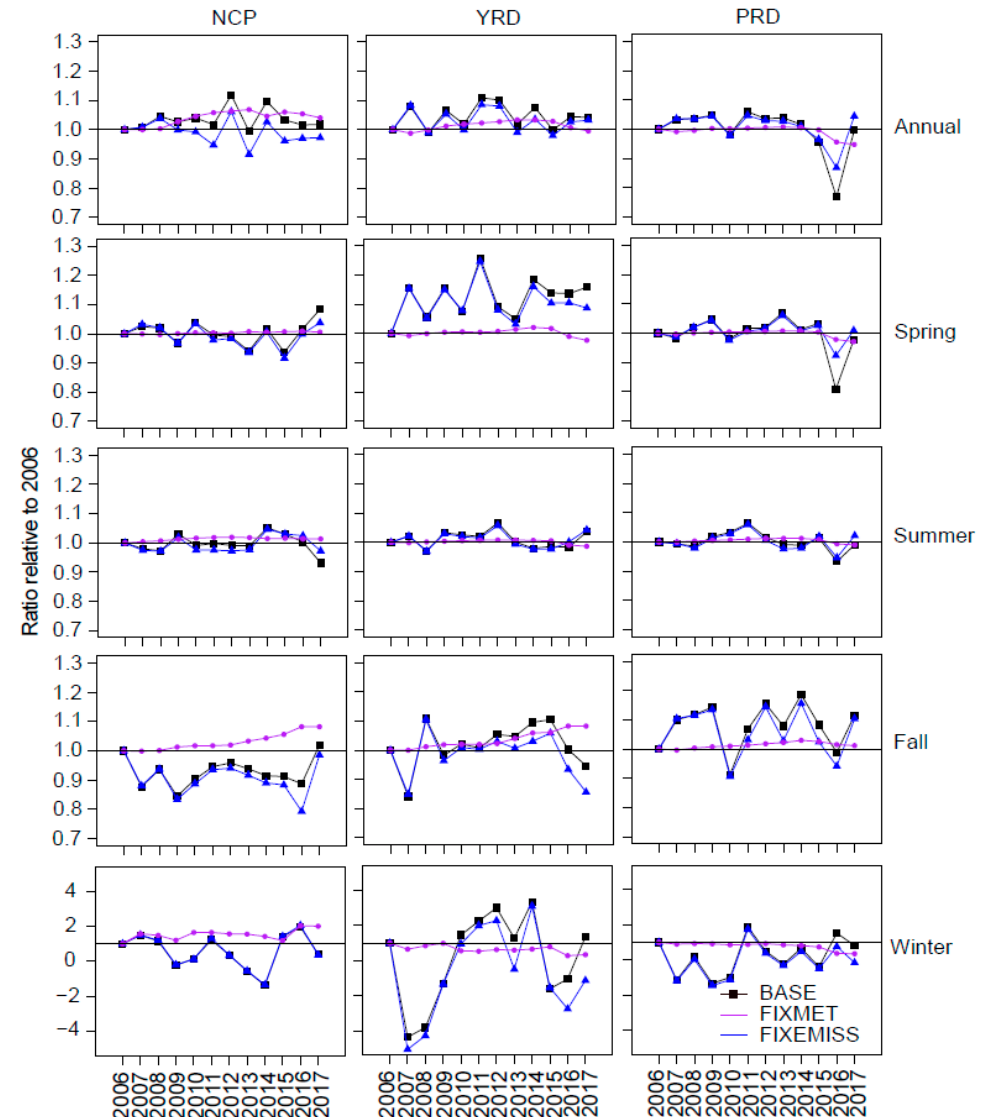
Figure 5. Annual and seasonal mean correlation coefficient of daily PM 2.5 and daily AOD (r PM-AOD ) relative to their values in 2006 in GEOS-Chem simulations in 2006–2017. Three experiments are shown: varying meteorology and varying emissions (BASE, black lines), varying anthropogenic emissions with meteorological fields fixed at the 2009 level (FIXMET, purple lines), varying meteorological fields with fixed anthropogenic emissions at the 2006 level (FIXEMISS, blue lines).